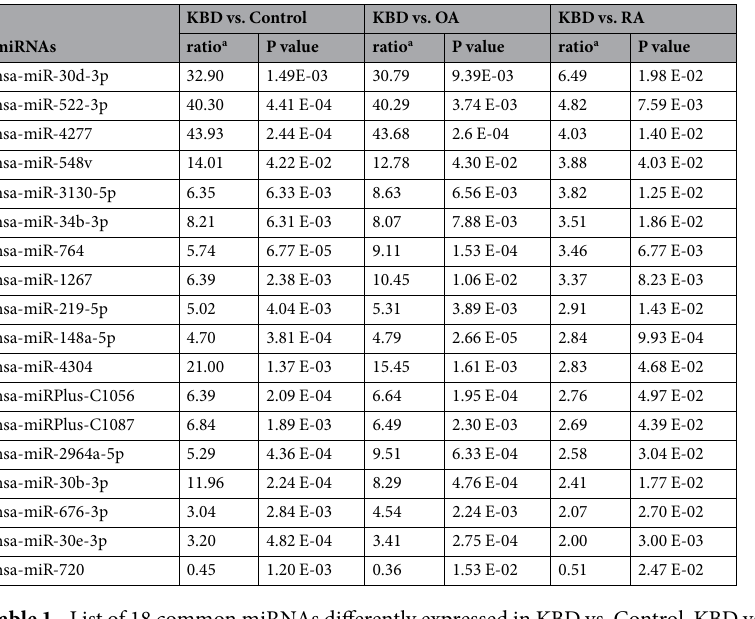
Table 1. List of 18 common miRNAs differently expressed in KBD vs. Control, KBD vs. OA and KBD vs. RA. a The differently expressed miRNAs passed volcano plot filtering and were identified at fold changes ≥ 2.0 and P -value ≤